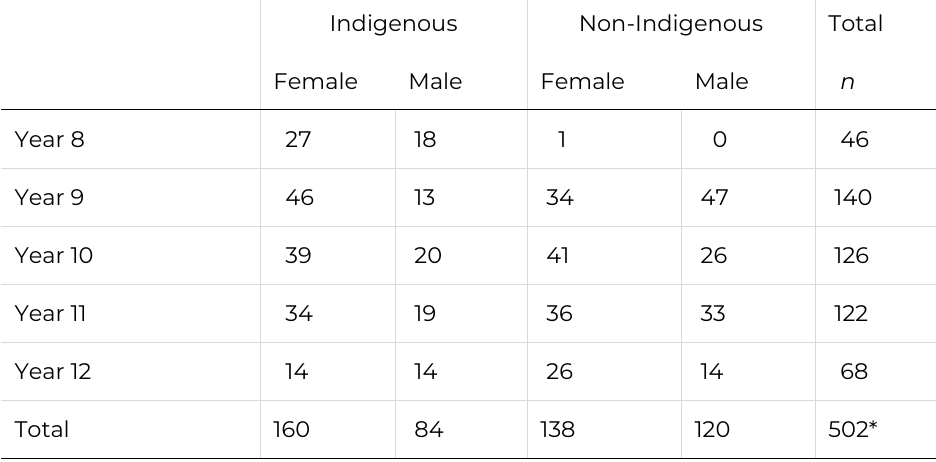
Table 1. Respondents by school year, Indigenous status and gender Indigenous Non-Indigenous